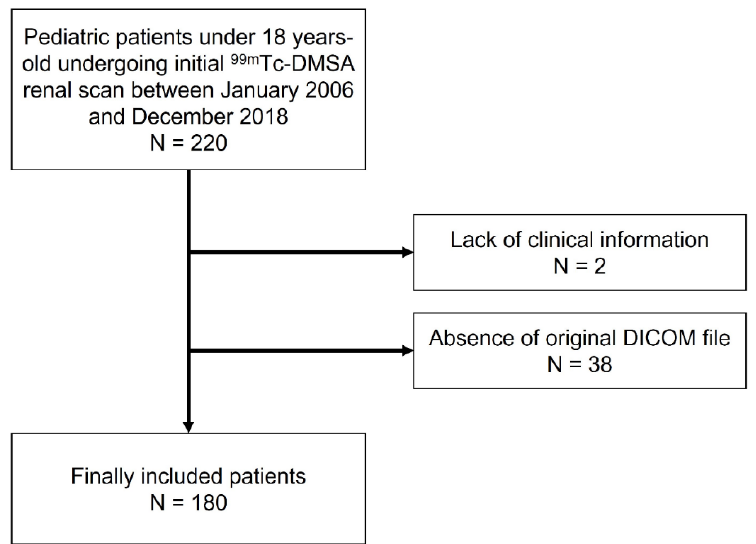
Figure 1. Patient inclusion and exclusion criteria. Two hundred and twenty patients were retrospectively enrolled. Among them, patients with a lack of clinical information or without an original DICOM file were subsequently excluded. Ultimately, 180 patients were included.